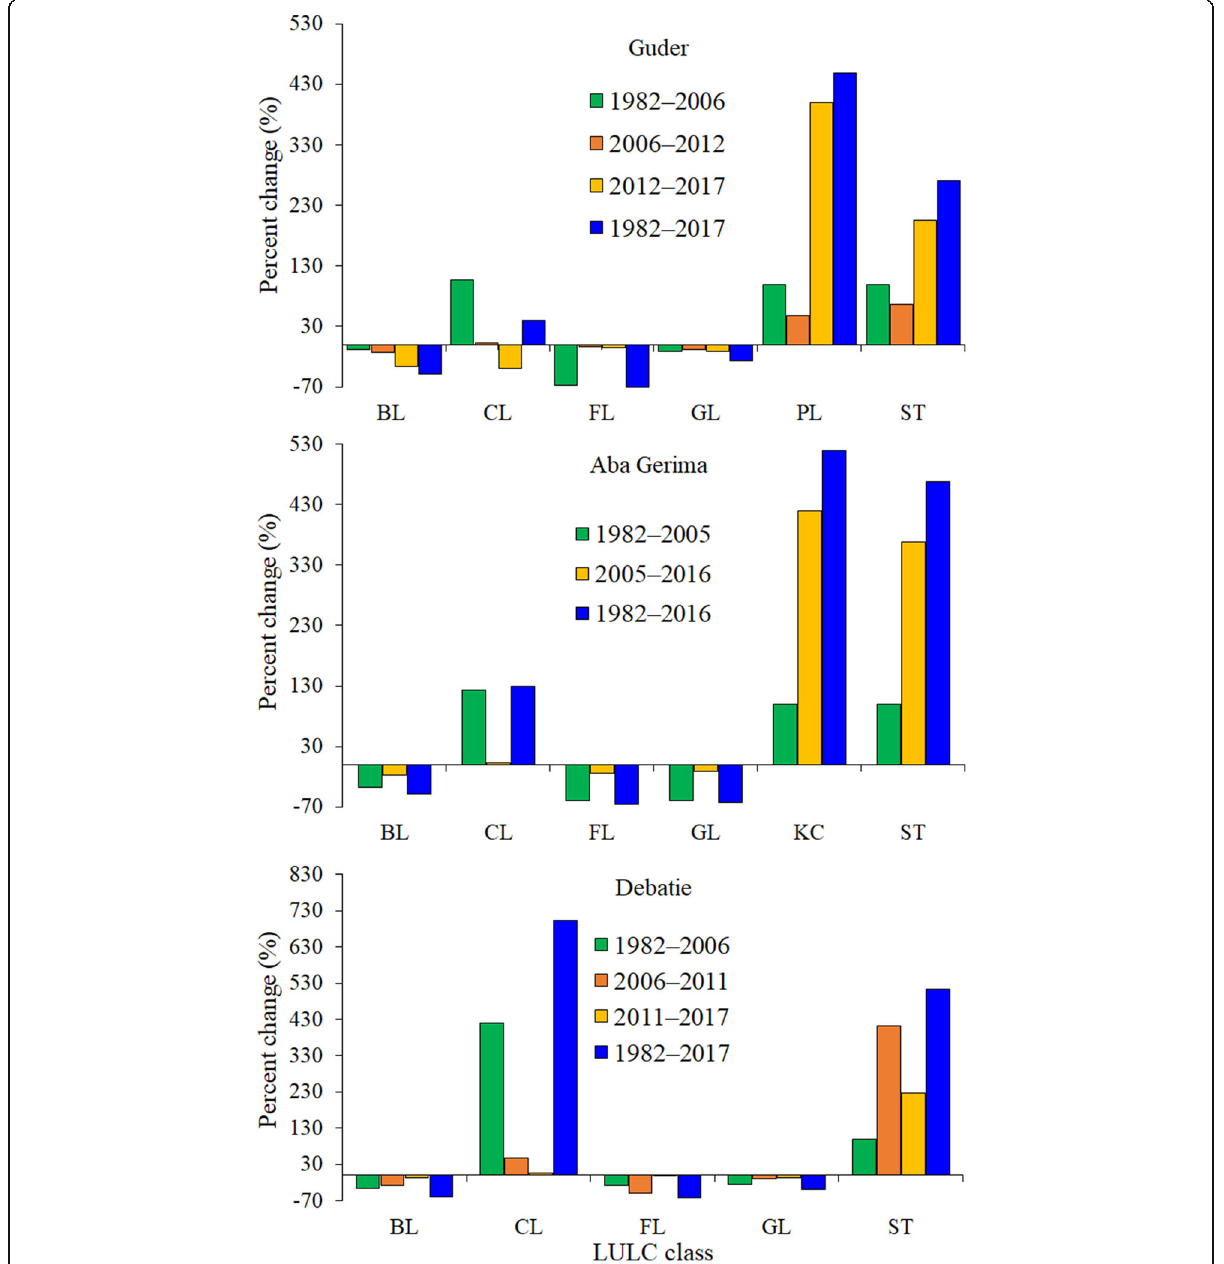
Fig. 2 Percent change (%) in land-use/land-cover (LULC) classes for Guder, Aba Gerima, and Debatie watersheds, Ethiopia (LULC abbreviations